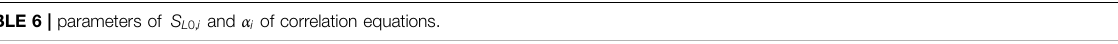
TABLE 6 | parameters of S L 0 , i and α i of correlation equations. Reference S L0 parameters Slope of Log (S L )-log (T/T 0